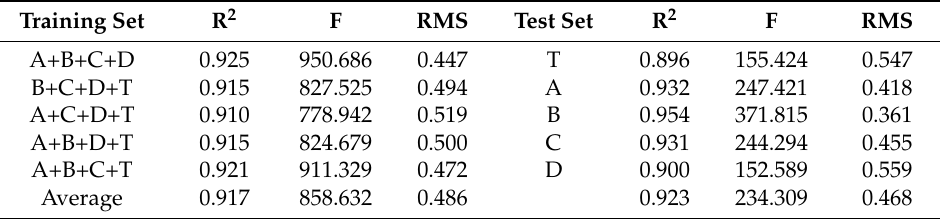
Table 8. Validation of the RBFNN